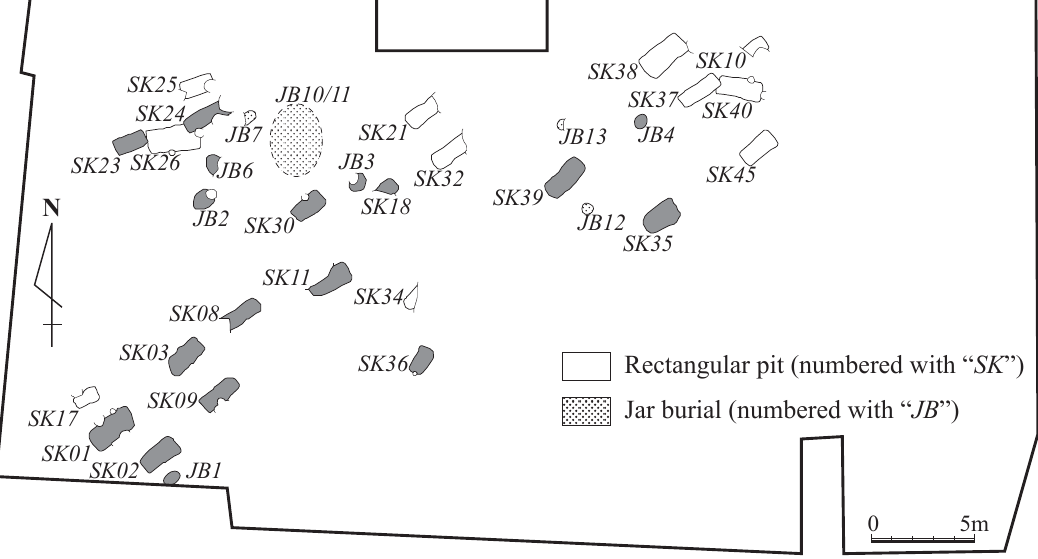
Figure 3. Distribution map of the two types of burial in the Mochida-Cho San-Chome site. The burial area is clearly carefully chosen, and the axis is parallel. The long axis of every pit grave is uniformly lined in a NE-SW direction, and almost no overlap is evident in grave pits and jar burials. Shaded burials are those which have pottery analysed in this paper. (after Ehime Pre- fecture Archaeology Center